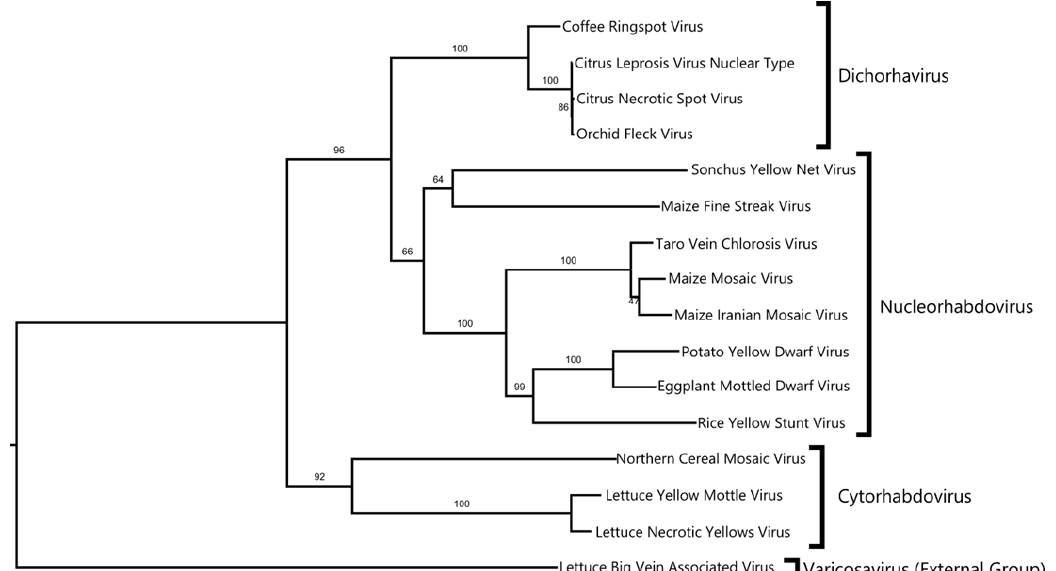
Figure 4. Phylogenetic reconstruction for RNA-dependent RNA polymerase sequences. Tree construction is based on the maximum likelihood model with a bootstrap value indicated above supported branches. The proposed Dichorhaviruses are grouped in a single